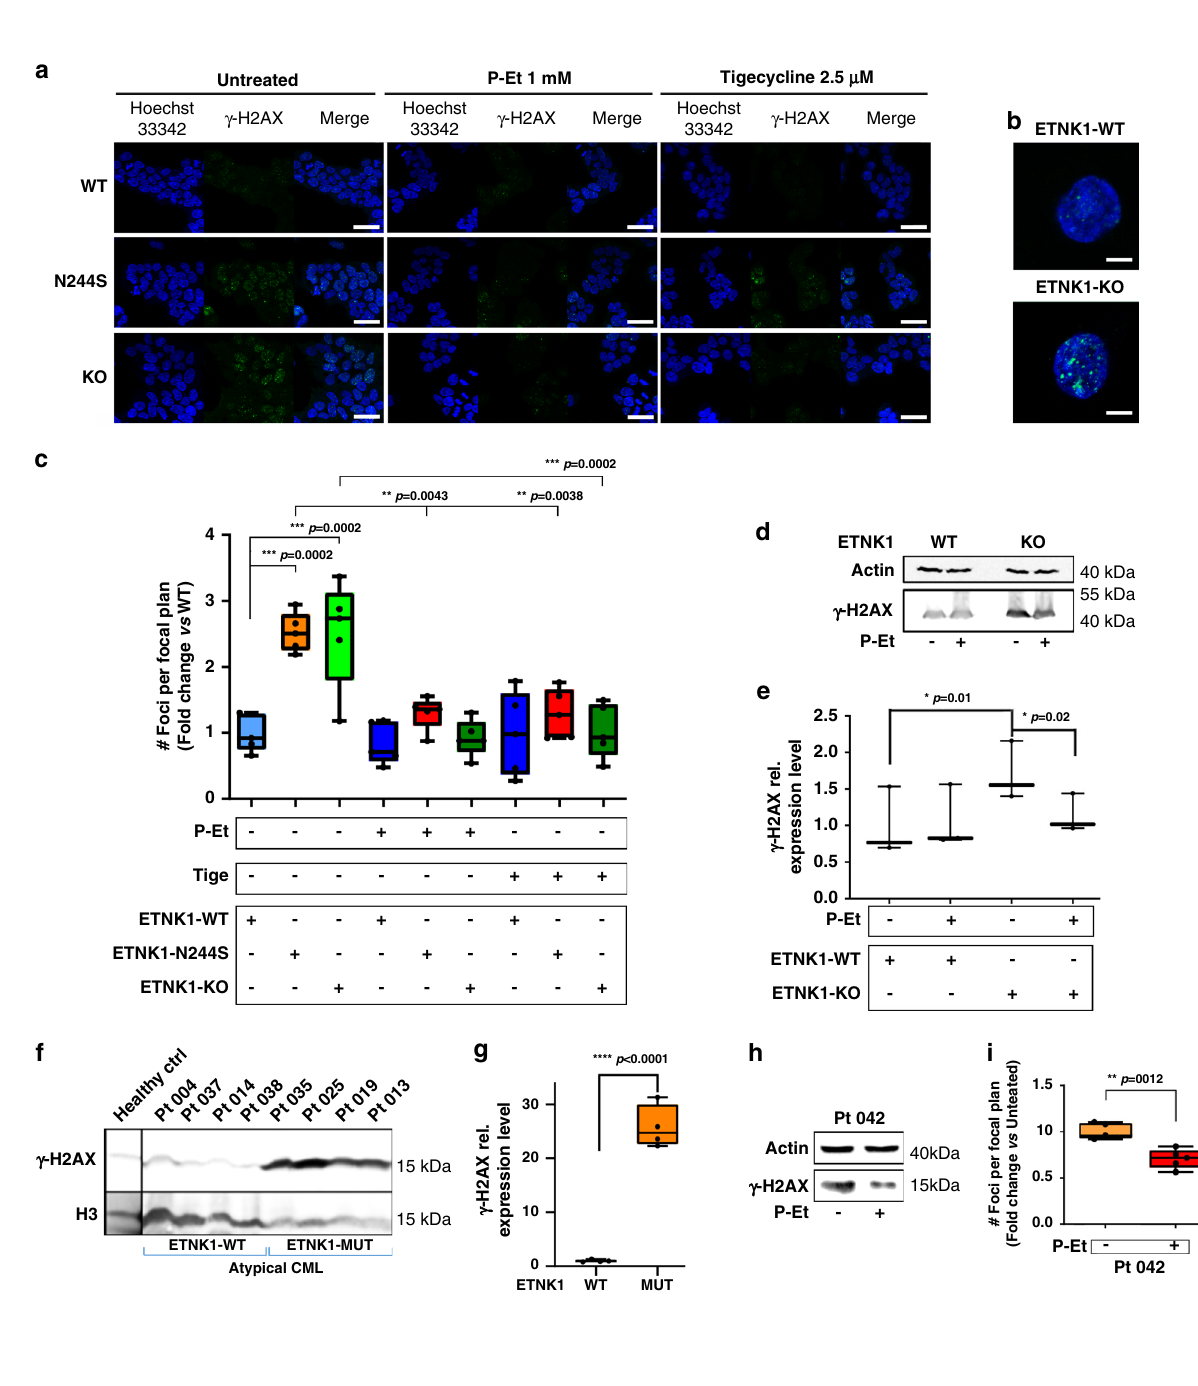
Fig. 4 Oxoguanine analysis and 6-thioguanine resistance. a Diagram showing the chemical reaction responsible for the generation of oxoG from G after exposure of gDNA to reactive oxygen species. b Scheme of the oxoG-mediated DNA damage. In the presence of the modi fi ed base, the gDNA may undergo two different destinies: either the base is excised, owing to the recruitment of the oxoG DNA glycosylase 1 (OGG1) repair machinery before the onset of a new replication cycle, or it causes the misincorporation of an adenine in the complementary strand, eventually leading to a G:C to T:A transversion. c Per-chromosome quanti fi cation of oxoG binned read counts in ETNK1-WT and N244S CRISPR lines following total read counts normalization; ( n = 2). Statistical analysis was performed using a Wilcoxon matched-pairs signed rank test. d Mutation frequency assessed by 6- thioguanine assays in ETNK1-WT, N244S, and KO CRISPR lines in the absence or presence of 1 mM P-Et or 2.5 µ M tigecycline (cell were pretreated for 15 days; 1 million of cells was plated and exposed to 30 μ M of 6-TG for 15 days, while 1500 cells were plated for 15 days, as control). The boxplots delimit the interquartile range; the central bar represents the median; the whiskers extend from minimum to maximum ( n = 3 independent experiments). Statistical analyses were performed using one-way ANOVA with Tukey ’ s post-hoc correction. Source data are provided as a Source data fi